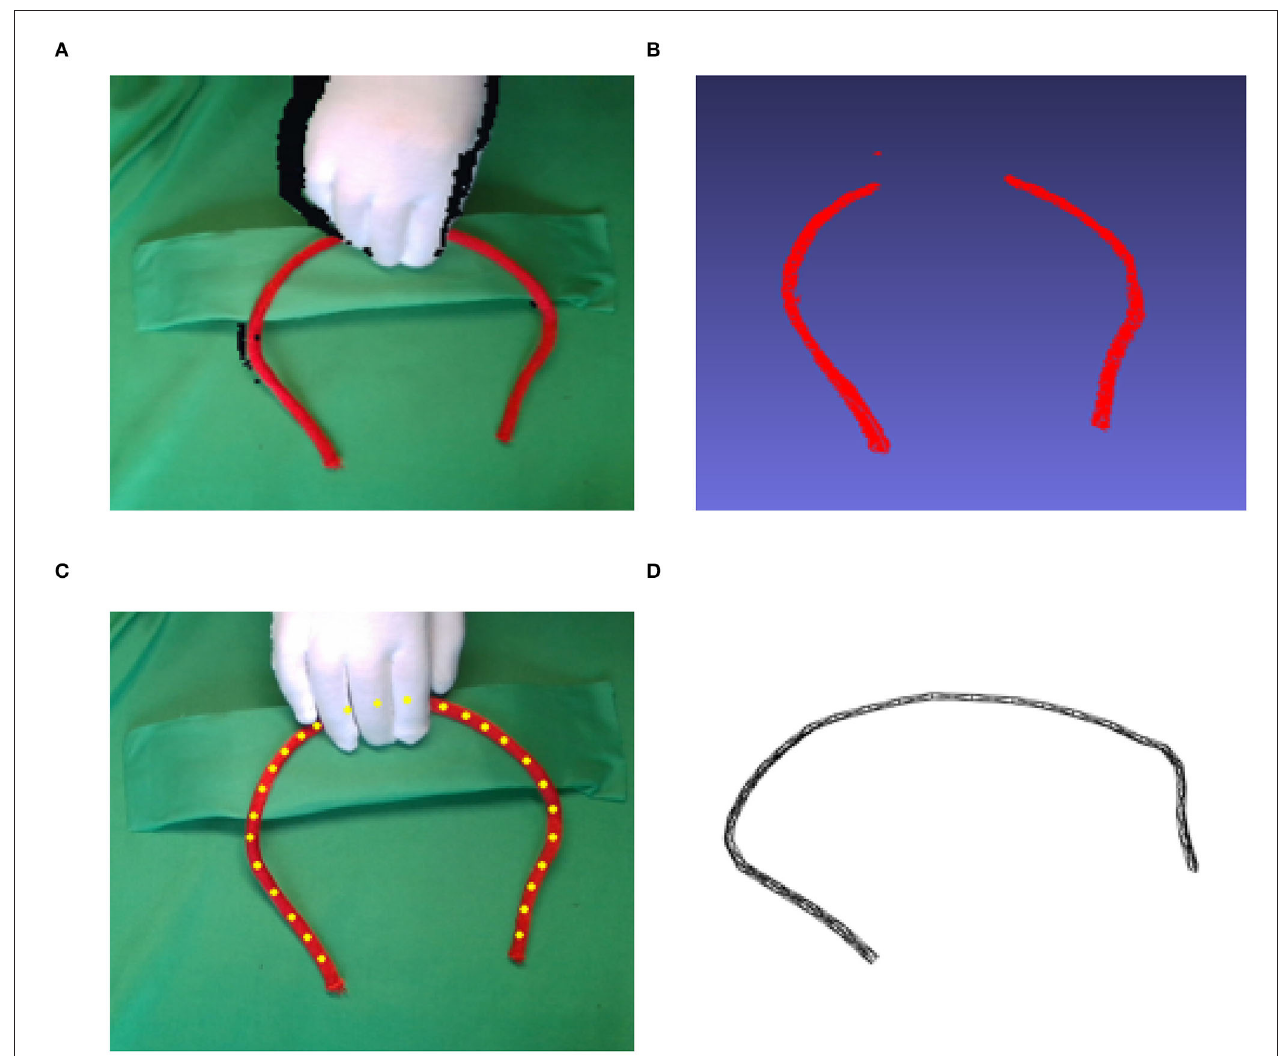
FIGURE 1 | Illustration of the occlusion caused by manipulation. (A) shows the depth image from an RGB-D camera. Image (B) is the 3D point cloud generated from the depth image (A) . The missing points are occluded by the hand. (C) is the Gaussian mixture model (GMM) tracking result from a point cloud. To accurately estimate the positions of the occluded part, we designed a 3D model, which is shown in (D) , to regulate the GMM results.